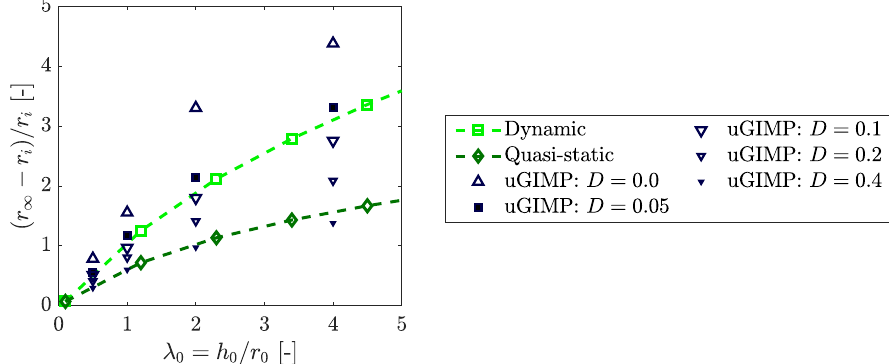
Figure A1. Normalised run-out distances with respect to an initial aspect ratio of column λ 0 for a variety of local damping coefficients D . Analytical solutions under quasistatic and dynamic hypotheses are also